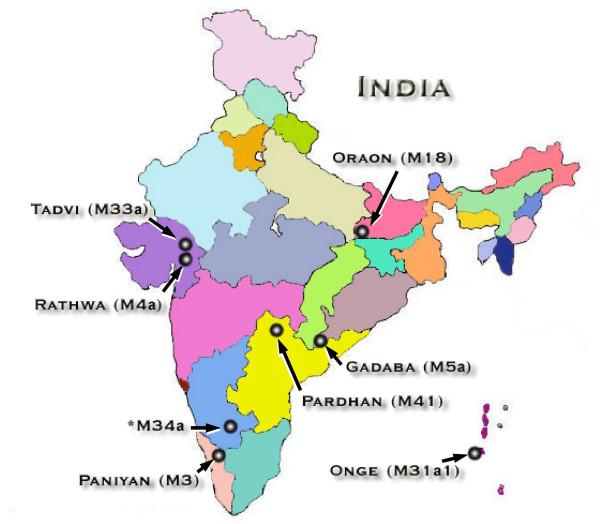
Geographical distribution of completely sequenced (mtDNA) samples used for the reconstruction of Indian M phylogeny. (*) Random sample from Karnataka state.